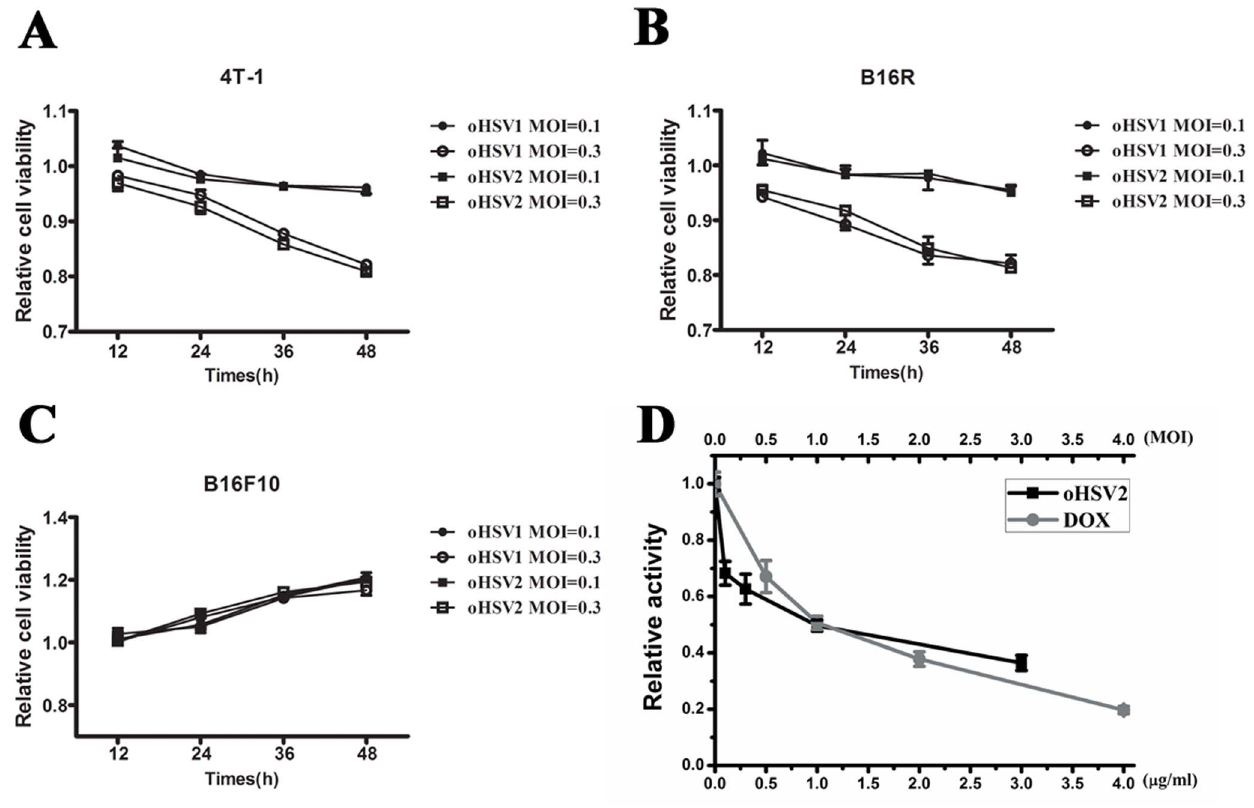
Figure 3. The cell viability of cancer cells was examined. A ) The 4T-1 cells were treated with oHSV1 or oHSV2 at the indicated MOIs for the indicated times. B ) The B16R cells were treated with oHSV1 or oHSV2 at the indicated MOIs for the indicated times. C ) The B16F10 cells were treated with oHSV1 or oHSV2 at the indicated MOIs for the indicated times. D ) The 4T-1 cells were treated with oHSV2 of different MOIs for 24h. DOX was used as a positive control. Each value represents the mean 6 SED of three independent samples.